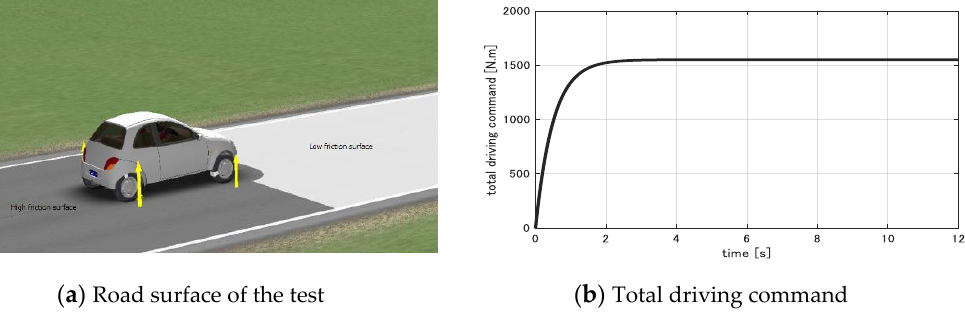
Figure 14. Simulation setting for evaluating passivity-based anti-slip control using DM-1.